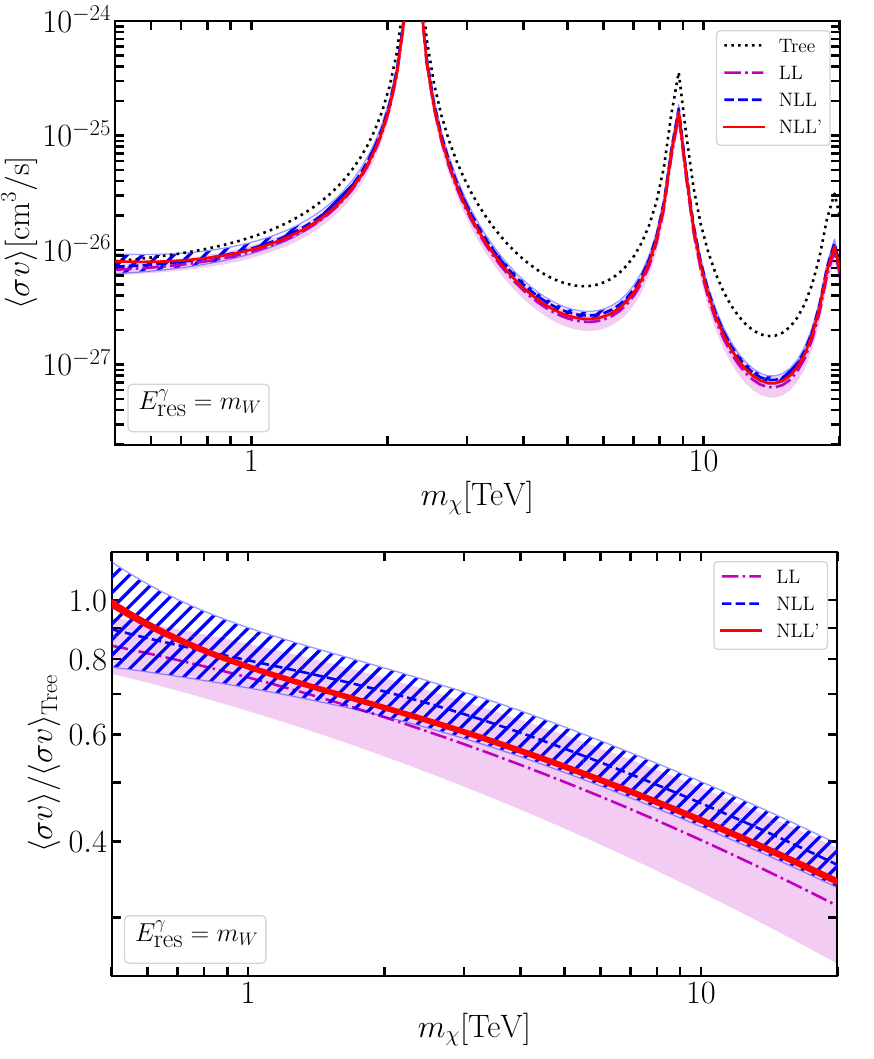
from the endpoint m χ in the tree res